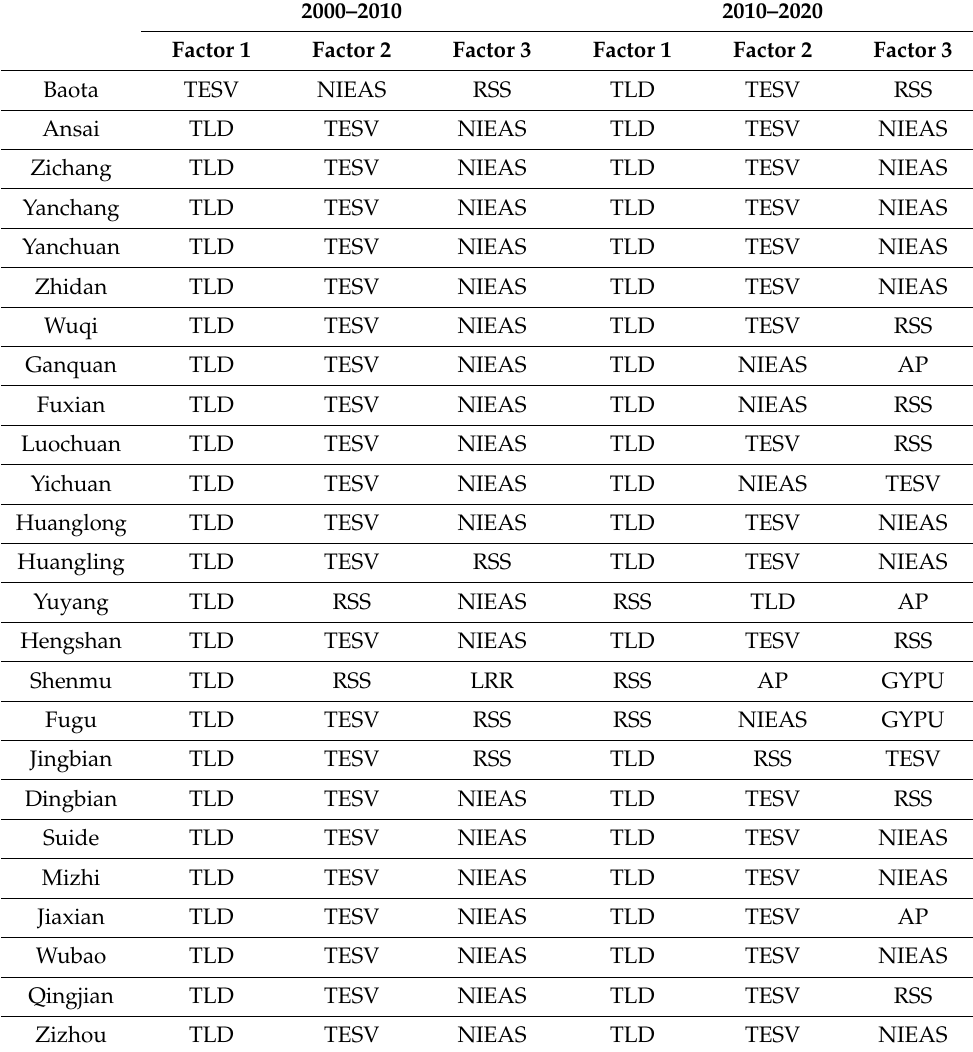
Table 2. The main barrier factors for enhancement of human settlement environment in northern